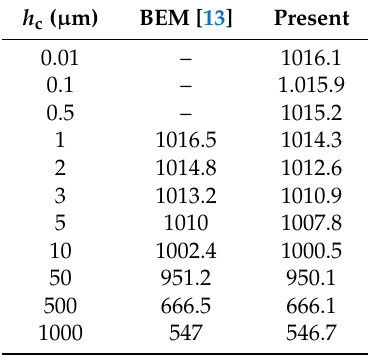
Table 4. Results at the specific point for different coating thickness in the third